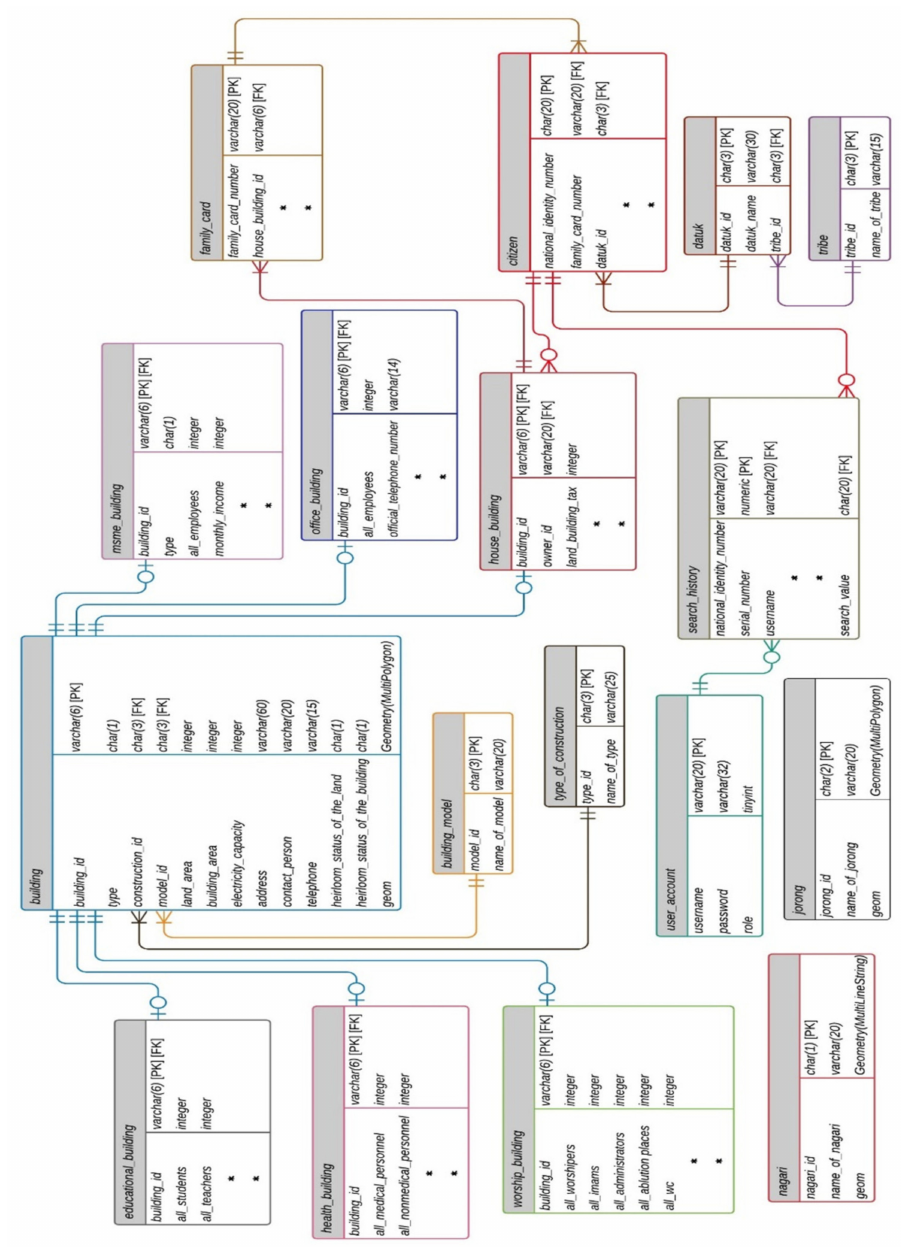
Figure 9. The ERD of the